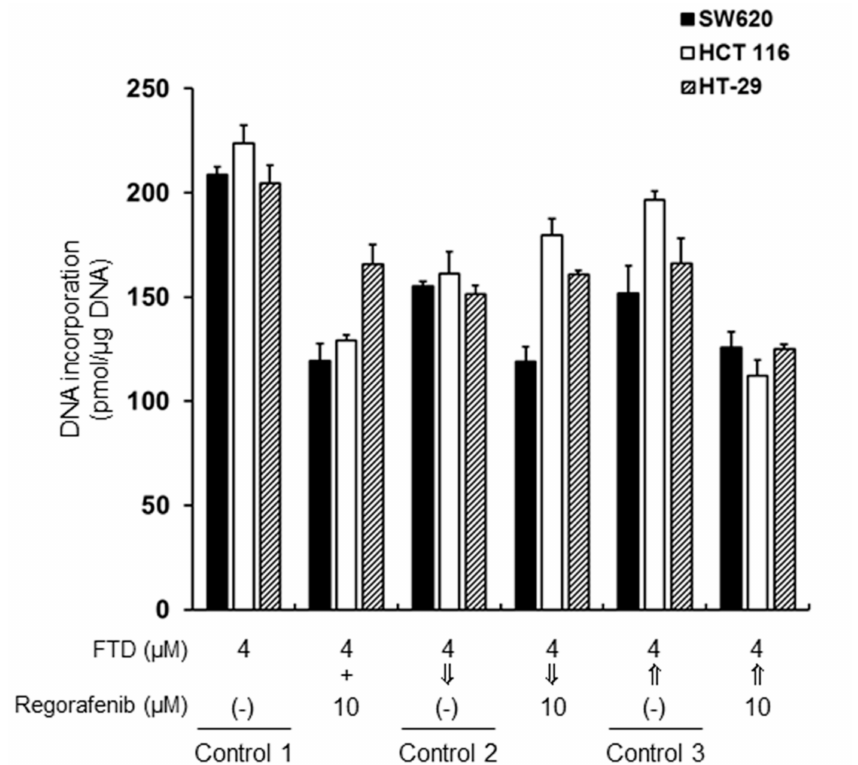
Figure 2. Incorporation of trifluridine (FTD) into DNA. SW620, HCT 116, and HT-29 cells were treated with 4.0 µ M FTD and 10.0 µ M regorafenib for 24 h, 4.0 µ M FTD for 24 h followed by 10.0 µ M regorafenib for 24 h, or regorafenib followed by FTD. Double-stranded DNA was extracted, and FTD incorporation was determined via liquid chromatography/tandem mass spectrometry (LC/MS/MS). Data are presented as the mean + SD ( n =